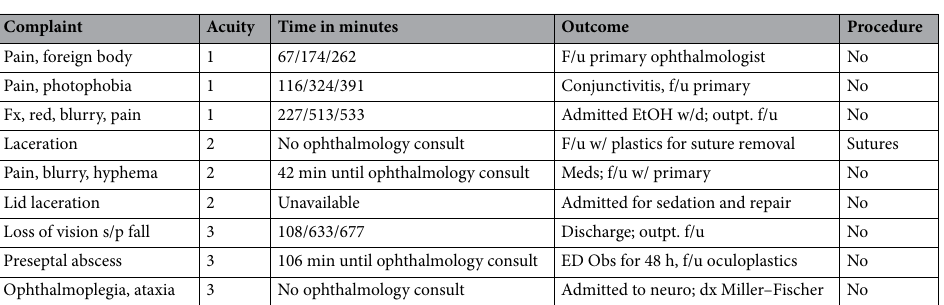
Table 1. Descriptions and outcomes of transfers to the ED from outside hospitals. The timing section refers to: minutes between triage and transfer note/consult note creation/consult note signature.